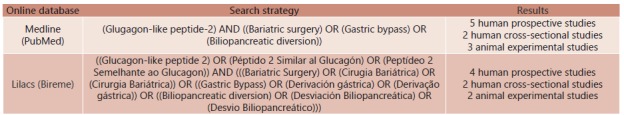
Results of the search in the online databases for the influence of bariatric/metabolic surgery on the release of GLP-2